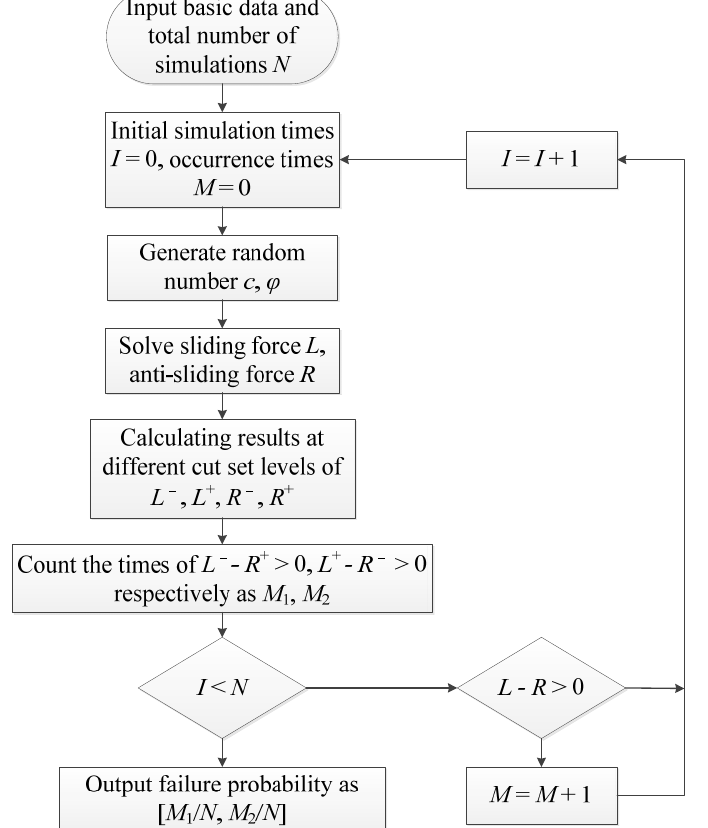
Figure 1. Flow chart of risk interval calculation based on the Monte-Carlo method. Table 1. Risk thresholds of instability failure for earth–rock dams